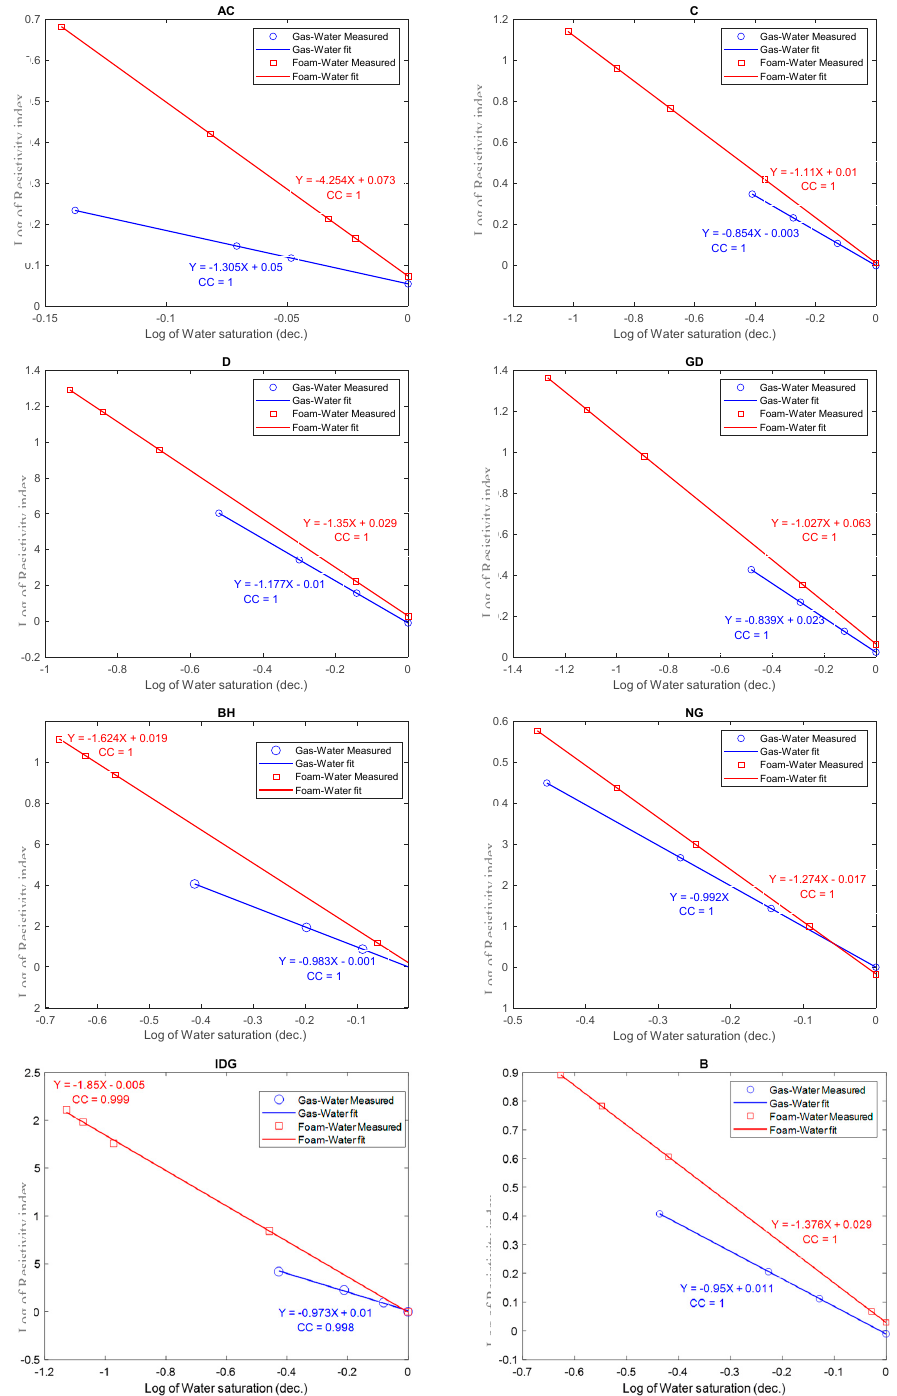
Figure 8. Comparison of the resistivity index curves for gas–water and foamed gas–water in different rock samples.